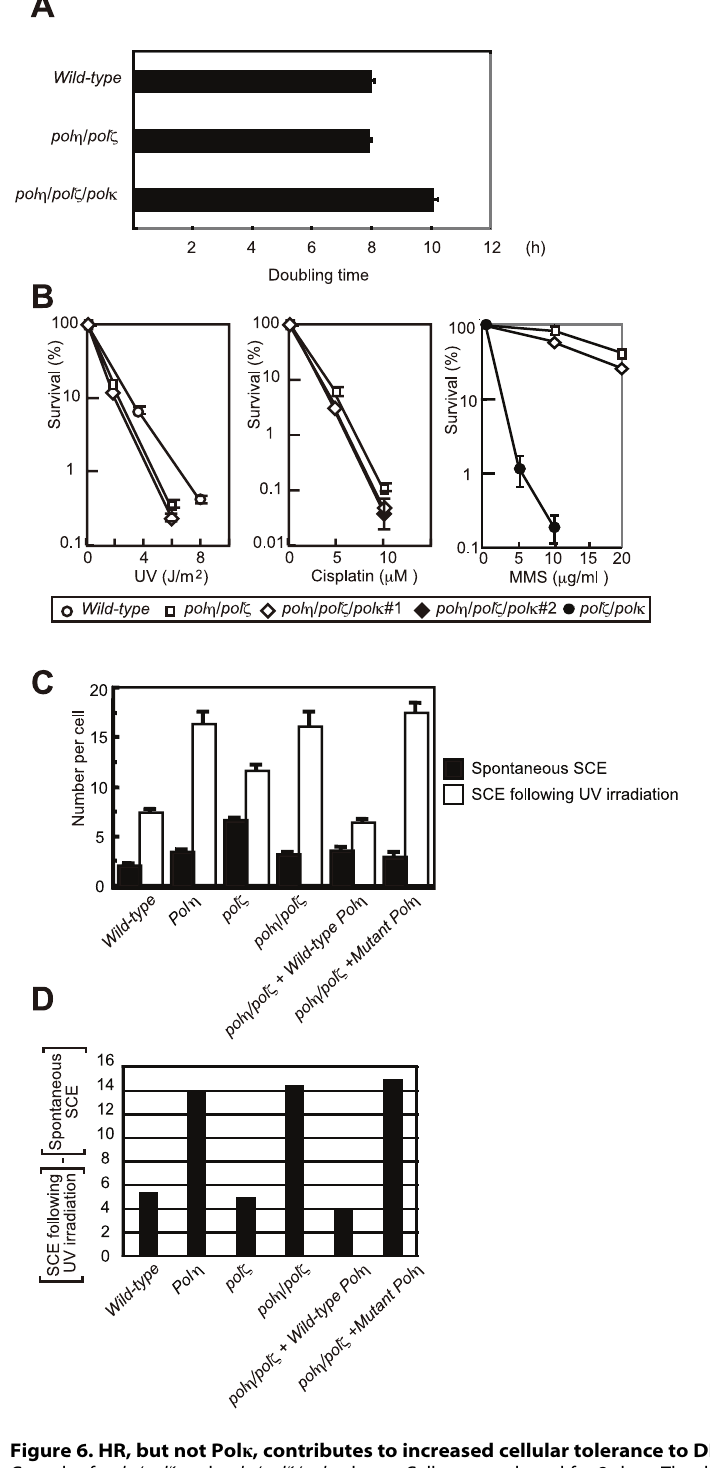
Figure 6. HR, but not Pol k , contributes to increased cellular tolerance to DNA damage in pol g /pol f cells, compared with pol f cells. (A) Growth of pol g /pol f and pol g /pol f /pol k clones. Cells were cultured for 3 days. The doubling time of each mutant is shown. Error bars show the SD of the mean for three independent assays. (B) Sensitivity profiles of indicated mutant cells to UV and cisplatin. Error bars show the SD of the mean for three independent assays. (C) Induction of SCE in pol g , pol f , and pol g /pol f cells by UV. Cells were labeled with BrdU during over cell-cycles with or without UV irradiation (0.25 J/m 2 ) before labeling. Spontaneous and induced SCEs in the macrochromosomes of 50 metaphase cells were counted. Histograms show the frequency of cells with the indicated numbers of SCEs per cell. The mean number of SCEs per cell 6 SE is shown. Statistical significance was further calculated by the non-parametric Mann-Whitney U test. (D) The number of UV-induced SCE was calculated by subtracting spontaneous SCE from SCE following UV